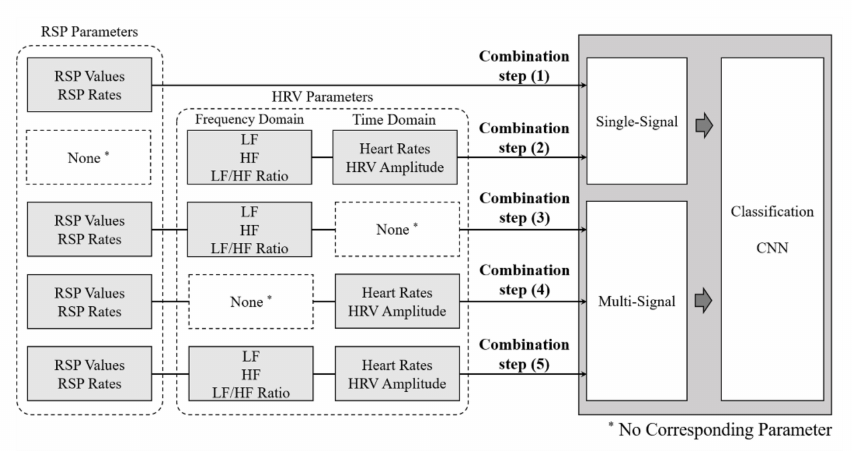
Figure 6. Parameter combination method of physiological